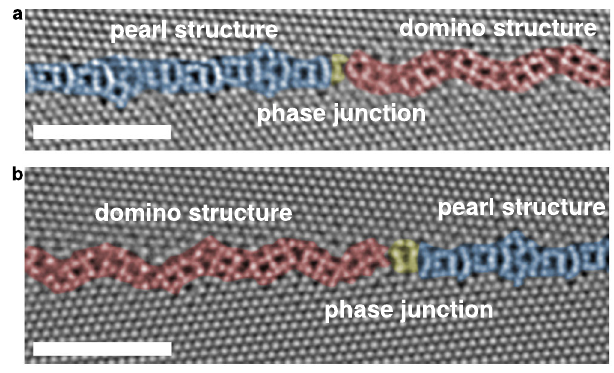
Fig. 1 HAADF-STEM images of two GB phases separated by phase junctions in a nearly symmetric Σ 37c 〈 111 〉 {1 10 11} GB. The GB plane remains unchanged by the phase transition and no faceting is observed. a , b Shows these junctions at two different positions on the same fi lm. The scale bars represent 2